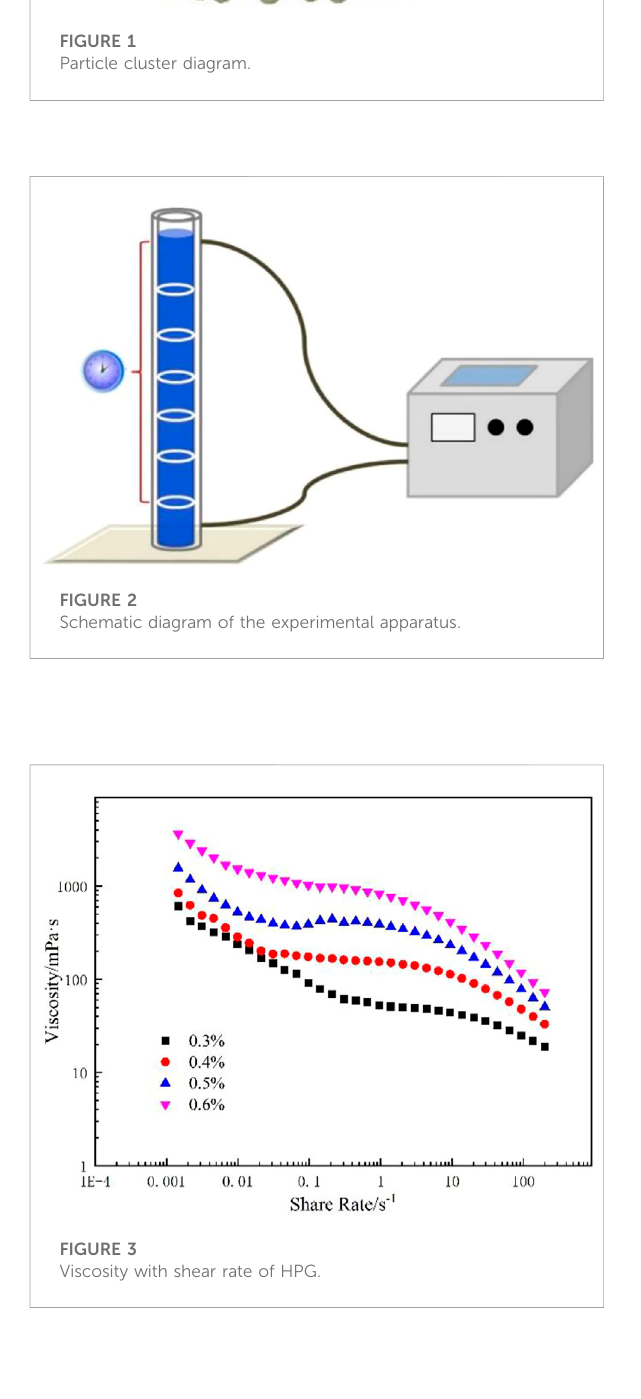
FIGURE 1 Particle cluster diagram.